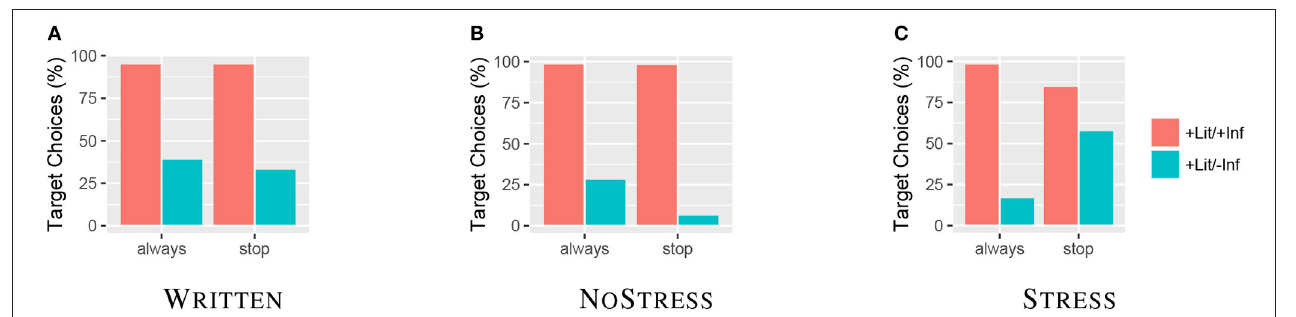
FIGURE 9 | Target selection rates across conditions for the “ WRITTEN ” (A) , “ NO-STRESS ” (B) , and “ STRESS ” (C)